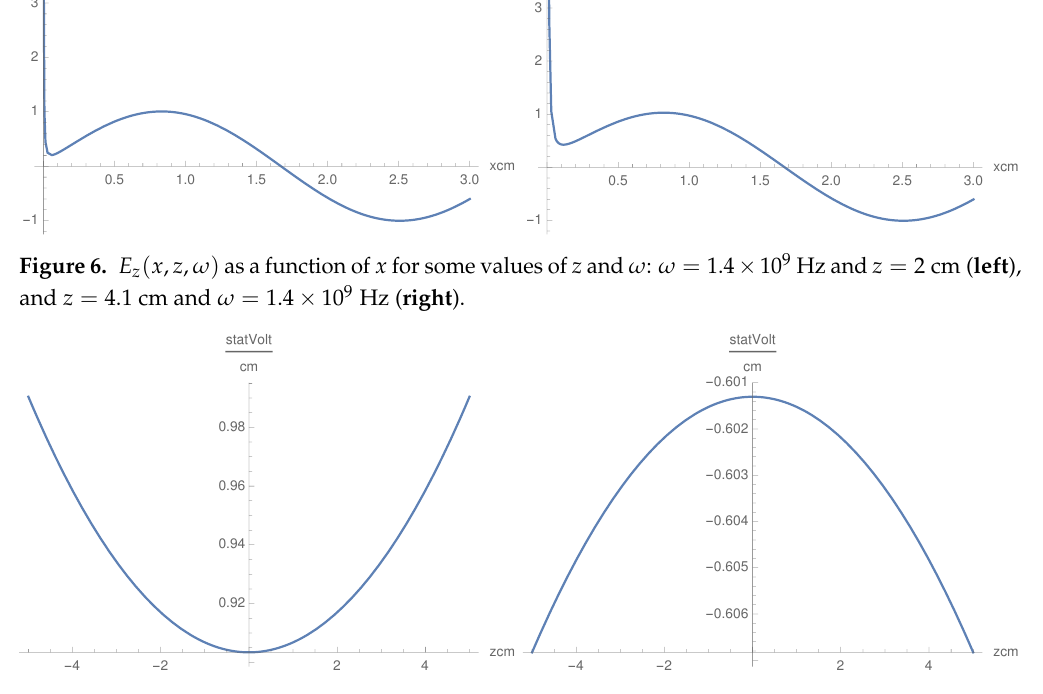
Figure 7. E z ( x , z , ω ) as a function of z for some values of x and ω : ω = 1.5 × 10 9 Hz and x = 0.5 cm ( left ), and x = 3 cm and ω = 1.5 × 10 9 Hz ( right